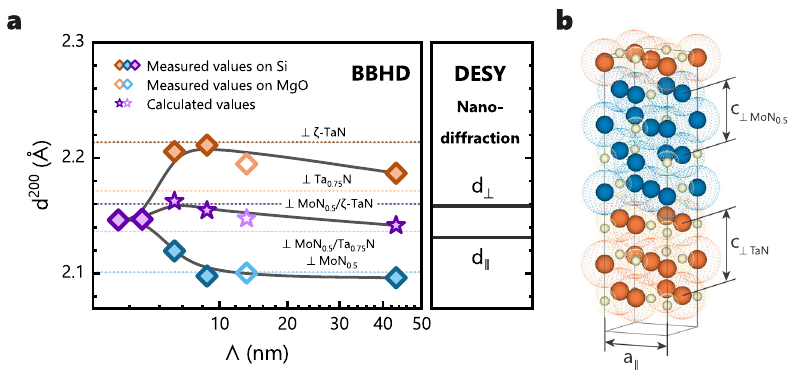
Fig. 5 Development of lattice parameter with increasing bilayer period. Diamond symbols in ( a ) show the obtained lattice plane distances from the XRD patterns of our superlattices on Si (100), Fig. 4a. The out-of-plane d 200 lattice planes for ζ -TaN, Ta 0.75 N, MoN 0.5 , MoN 0.5 / ζ -TaN, and MoN 0.5 /Ta 0.75 N are indicated with horizontal lines in ( a ). The results for the coating with Λ = 13.1 nm are obtained from fi lms grown on MgO, as their the 200 XRD peak was more distinct (compare Fig. 4 and Supplementary Fig. S1). Data points in stars are obtained by calculating the average. The right side of a shows in-plane and out-of-plane lattice plane distances obtained from our synchrotron experiments. In ( b ) the unit cell of the superlattice with Λ = 1.72 nm is